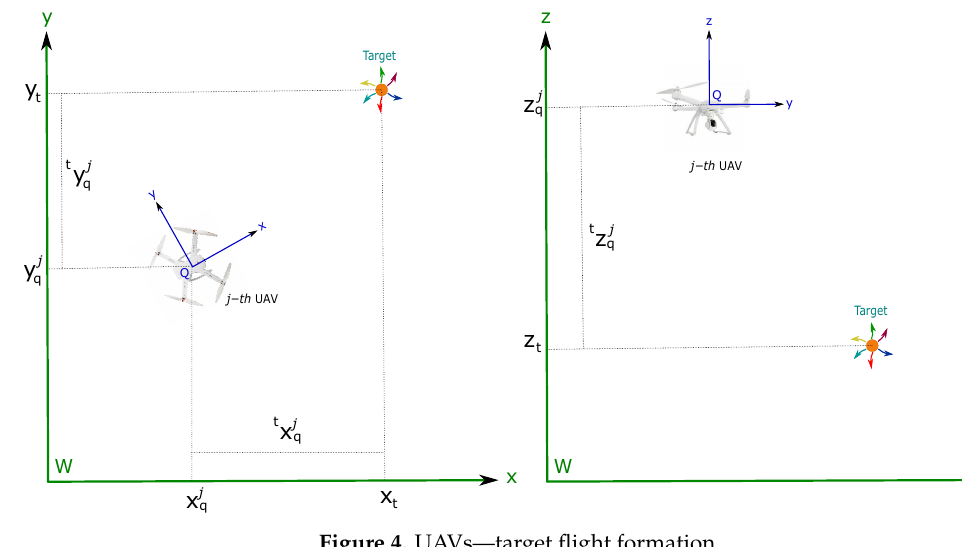
Figure 4. UAVs—target flight